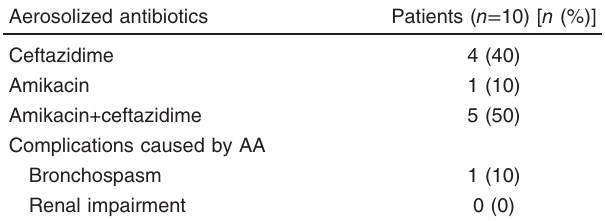
Table 7 Aerosolized antibiotics and their complications